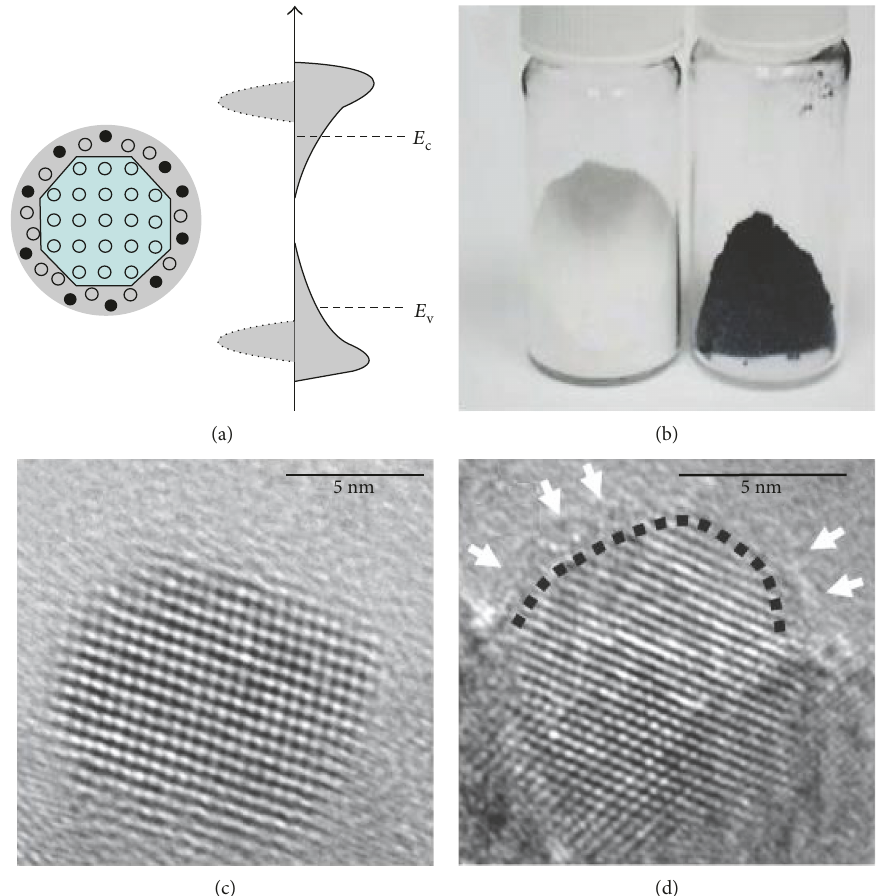
Figure 5: (a) Schematic illustration of the structure and electronic DOS of a disorder-engineered semiconductor nanocrystal with dopant incorporation. Dopants are depicted as black dots, and disorder is represented in the outer layer of the nanocrystal. E the conduction and valence levels of a bulk semiconductor, respectively. The intrinsic bands of the nanocrystal are shown at the left. The disorder-induced CB and VB tails extending into the otherwise forbidden levels are shown at the right. (b) Digital images of the white and black TiO nanocrystals. (c and d) HRTEM images of the white and black TiO 2 Copyright (2011) American Association for the Advancement of